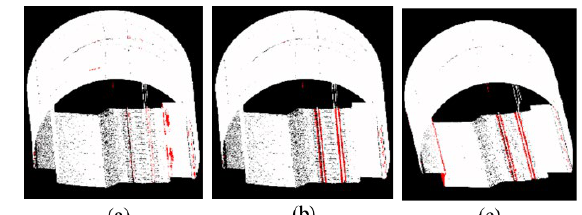
Figure 11. Misclassifications of the predictions in a manually labelled point cloud. (a) KPConv with transfer learning, (b) KPConv retrained, (c)